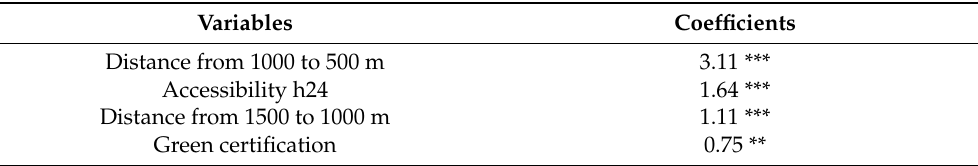
Table 3. Marginal willingness to pay.